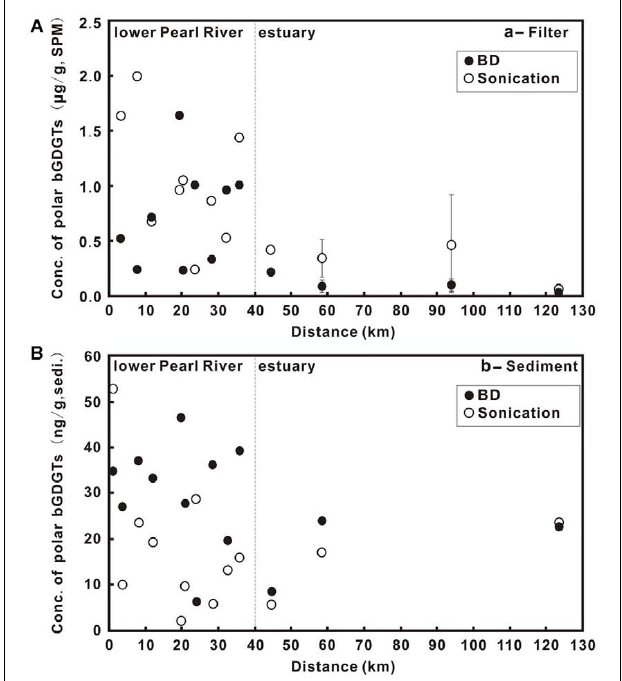
FIGURE 2 | Core (C)- and polar(P)-lipids (L) of bGDGTs in the water column (A) and sediments (B) from the lower Pearl River to the estuary. Zero distance is arbitrarily set at PR-9 in Figure 1 and increasing distance is toward the estuary.The error bars in (A) represent SD of the average values between the surface water- and the bottom water samples in the estuary.